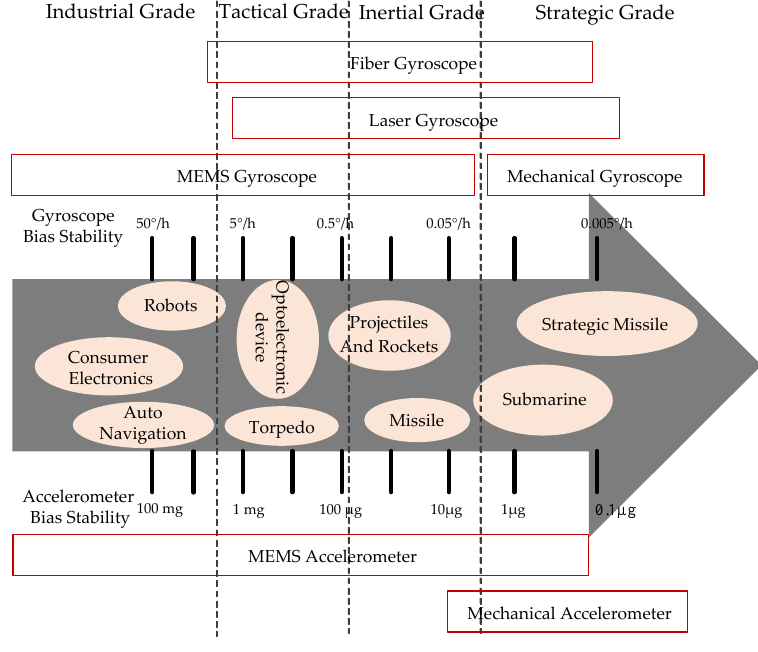
Figure 1. The bias stability of inertial sensors.